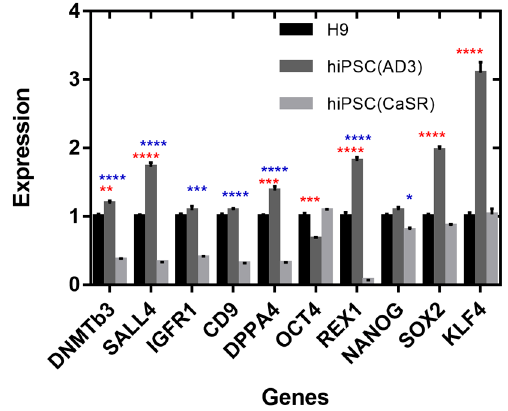
Figure 8. Relative expression of ten pluripotent genes measured in three cell lines using qRT-PCR. Data are presented as means ± SEMs. Values were normalized to the mean expression in the H9 line. Red asterisks point out the comparison of gene expression between hESC line H9 and hiPSC line AD3, and blue asterisks point out the comparison between hESC line H9 and hiPSC line CaSR. * p < 0.05; ** p < 0.01; *** p < 0.001; **** p <